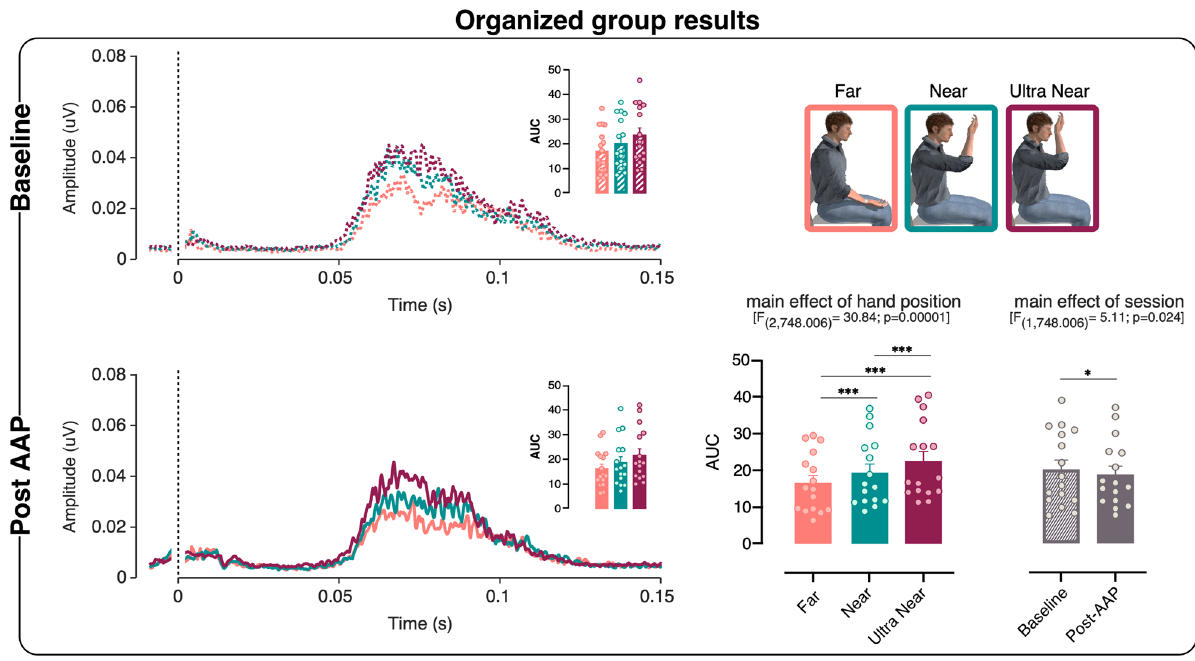
Figure 2. Organized group results. Left panels, rectified hand blink reflex (HBR) waveforms (group ‐ average) in the three different hand positions: Far (coral), Near (green), and Ultra Near (magenta). The dotted line at 0 s represents the stimulus delivery. The histograms represent the HBR magnitude (AUC) in the three hand positions. Bottom right panel, main effect of hand position. The error bars show the standard error of the mean (SEM) and the asterisk shows the significant difference (*p < 0.05). The dots represent individual participants. The images were created with the following software: Matlab R2020b (https:// it. mathw orks. com/ produ cts/ matlab. html) and GraphPad Prism 8 (https:// www. graph pad. com/ scien tific- softw are/ prism/) were used to plot the data. Canvas Draw (https:// www. canva sgfx. com/ produ cts/ canvas- x- draw) was then used to combine all components of the figure into a single